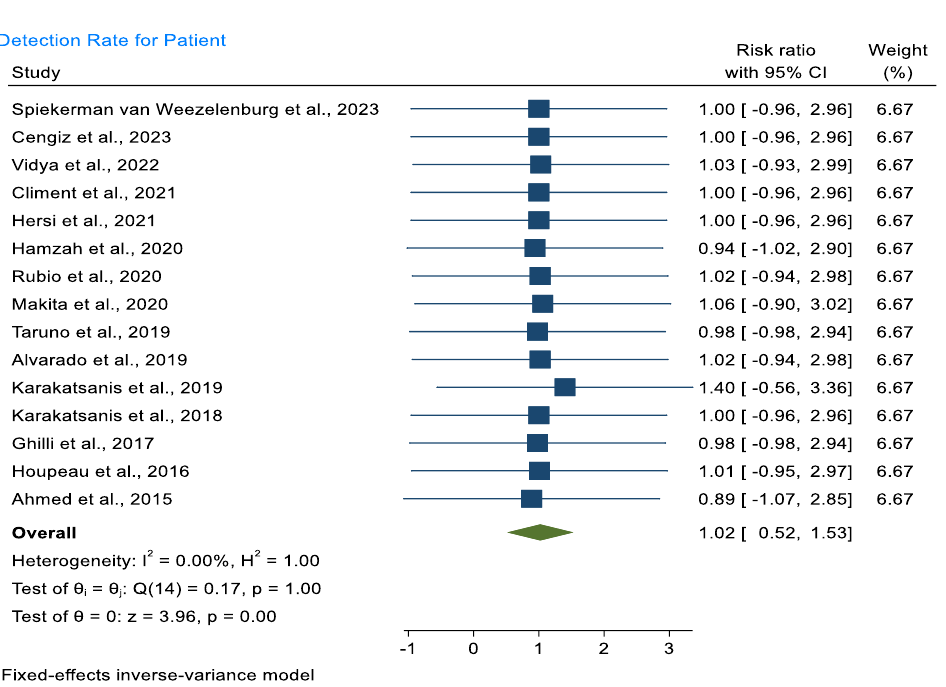
Fig. 2. The forest plot shows the Risk ratio of the patient detection rate.